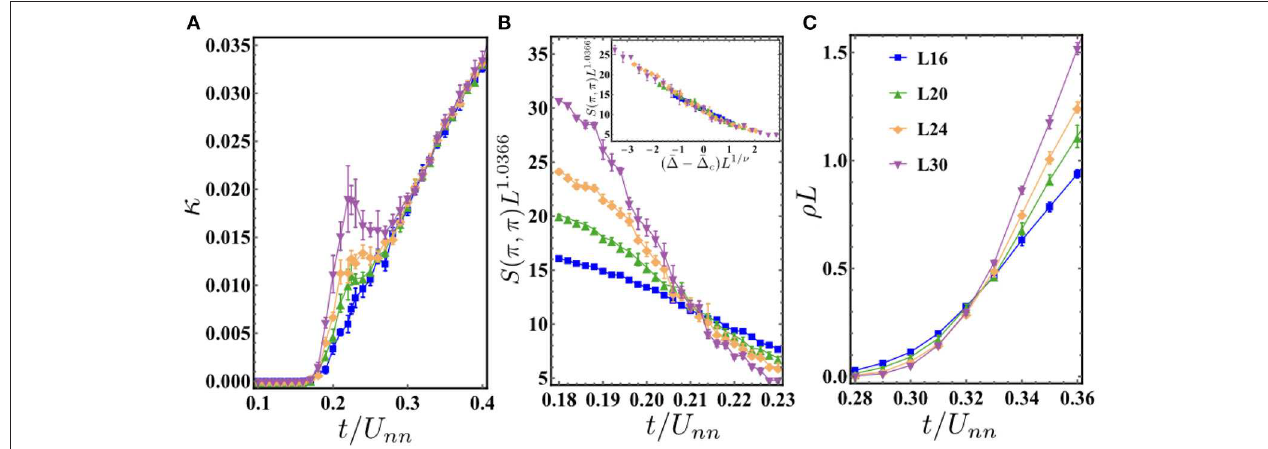
FIGURE 6 | Model 2 (nearest-neighbor repulsive interactions): all following results are at fixed disorder strength 1/ t = 5 and µ/ U nn = 2. (A) Compressibility κ as a function of t / U nn for different system sizes L = 16, 20, 24, and 30 (blue rectangles, green up triangles, orange diamonds, and purple down triangles, respectively). The DW to DS phase transition happens around t / U nn = 0.18 ± 0.01. (B) Finite size scaling result of S ( π , π ) for above system sizes. The crossing of different curves marks the transition point at t / U nn = 0.212 ± 0.01 for the DS to BG phase transition. Insert shows the data collapse result using ν = 0.67 and ¯ 1 c = ( t / U nn ) c = 0.212 corresponding to the critical point extracted from main plot. (C) Finite size scaling of superfluid stiffness ρ L as a function of t / U nn for above system sizes. The crossing of different curves marks the transition at t / U nn = 0.3241 ± 0.005 for the BG to SF phase